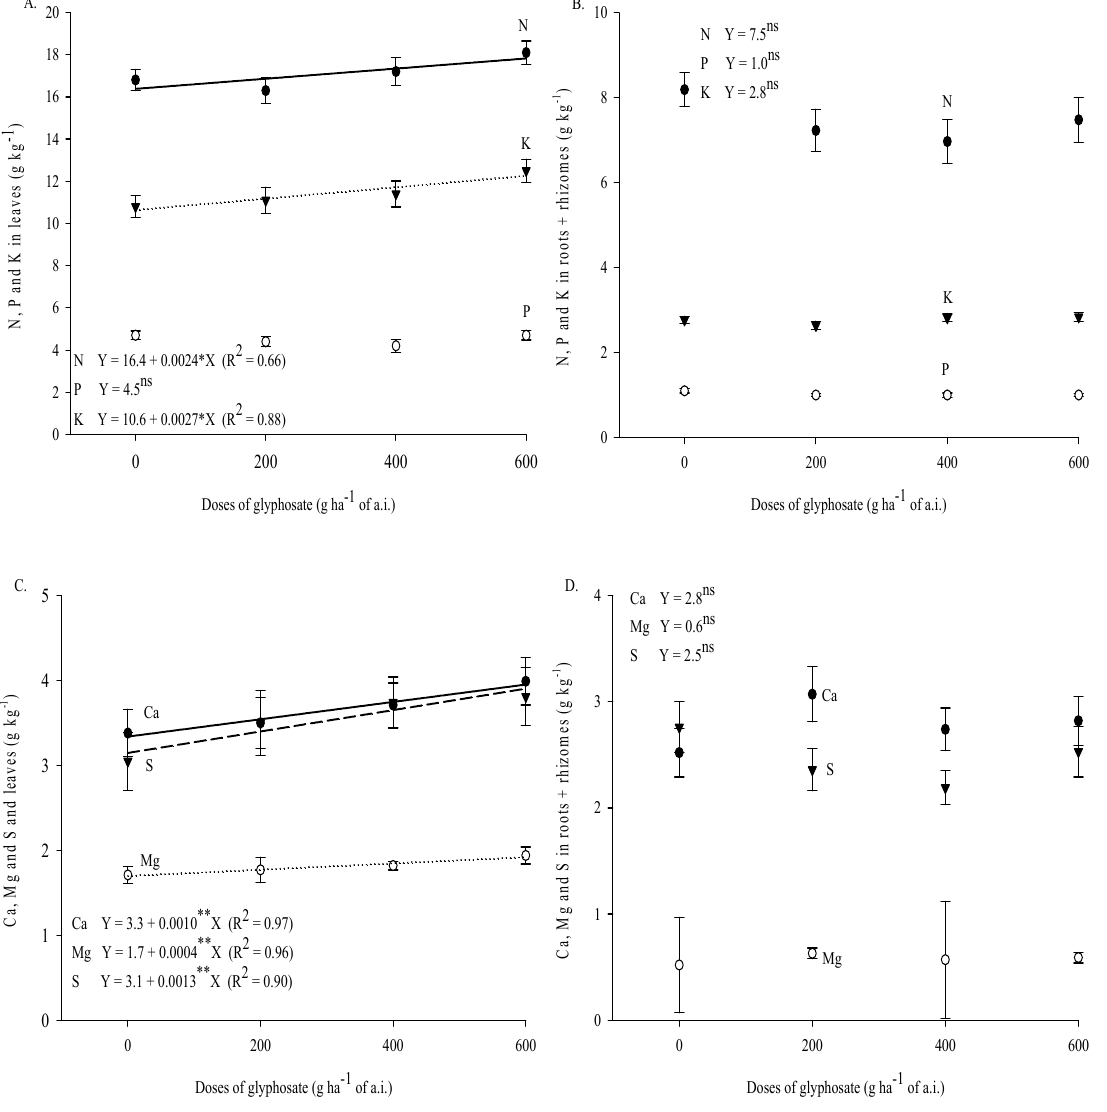
Figure 3. N, P and K concentrations of the leaves ( A ), roots and rhizomes ( B ), and the Ca, Mg and S in the leaves ( C ), roots and rhizomes ( D ) of the emerald grass as a function of doses of glyphosate. The letters correspond to a significant difference at the 5% probability level ( p ≤ 0.05). ns , ** and *: not significant, significant at p < 0.01 and 0.01 < p < 0.05, respectively. Error bars indicate the standard deviation of the mean ( n = 4).